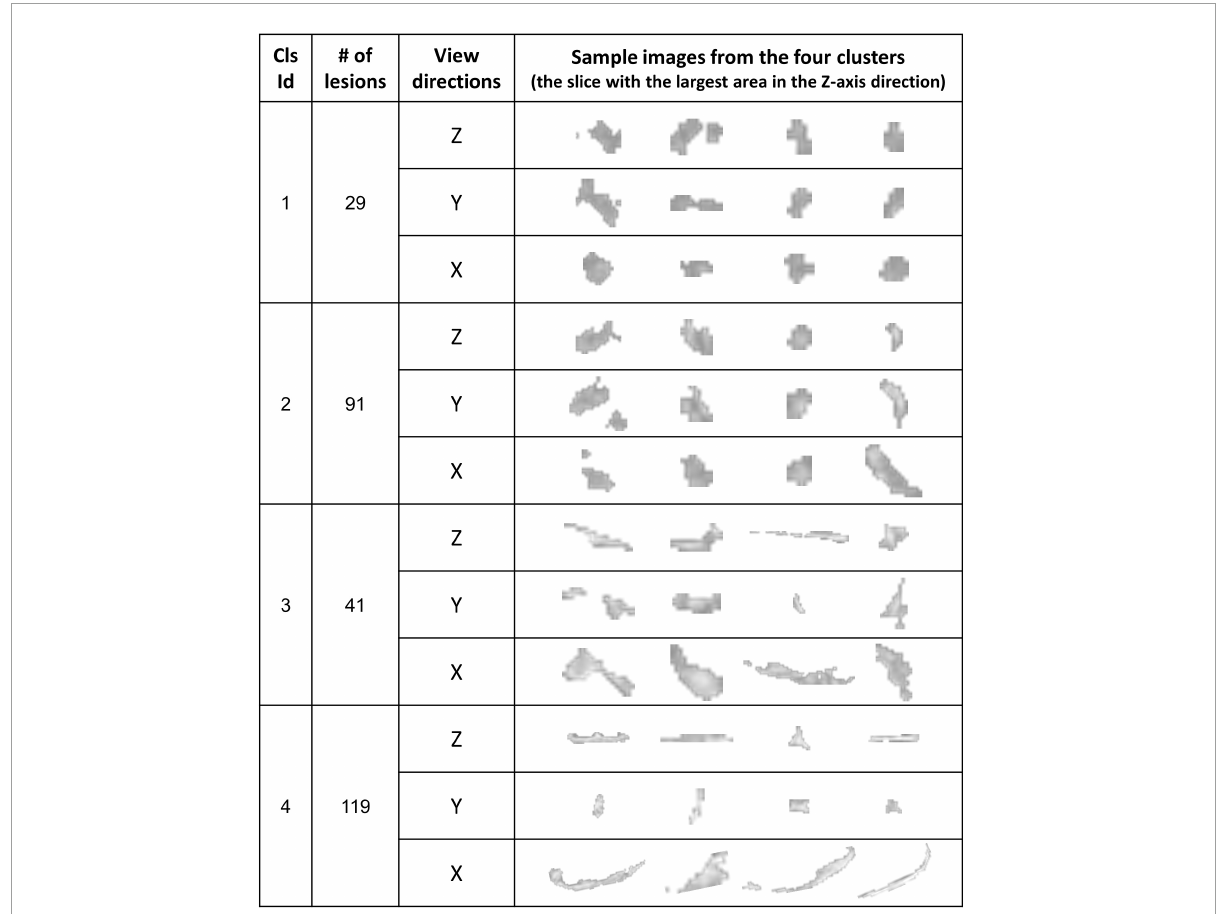
FIGURE8 The WMH3D lesion images from the 32 subjects were classified into four clusters. The images at three view directions are displayed.